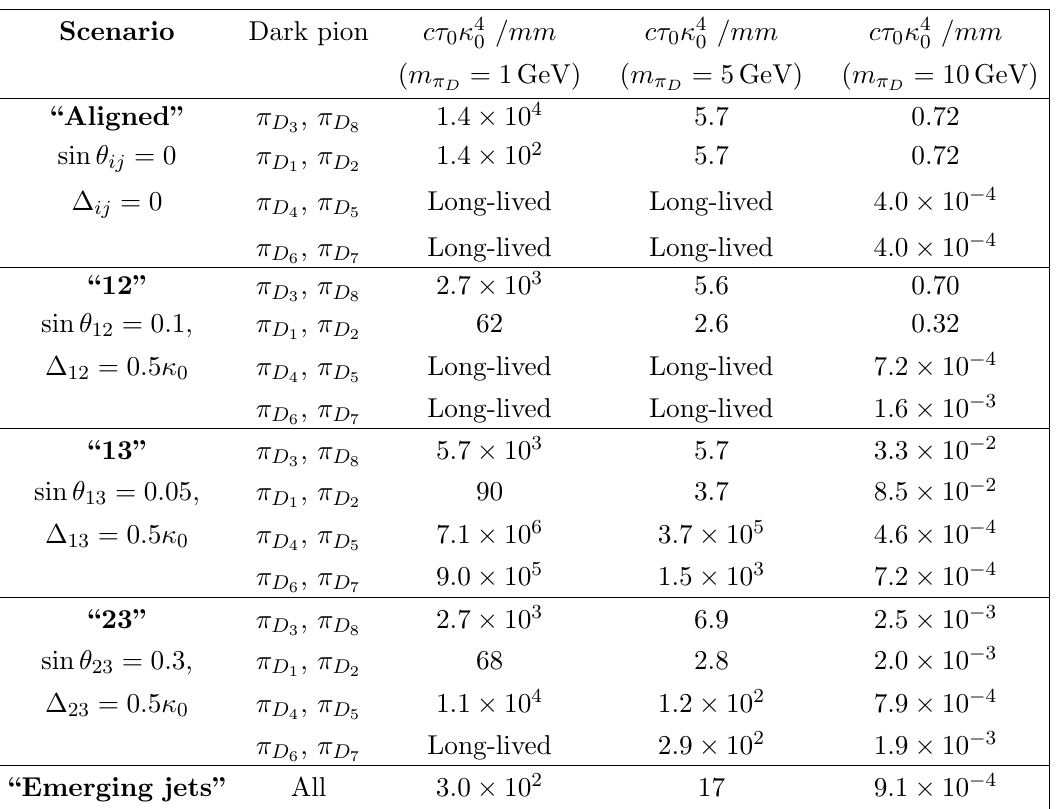
Table 3. Proper decay lengths ( c(cid:28) 0 ) of the dark pions, for various (cid:13)avour scenarios (see text